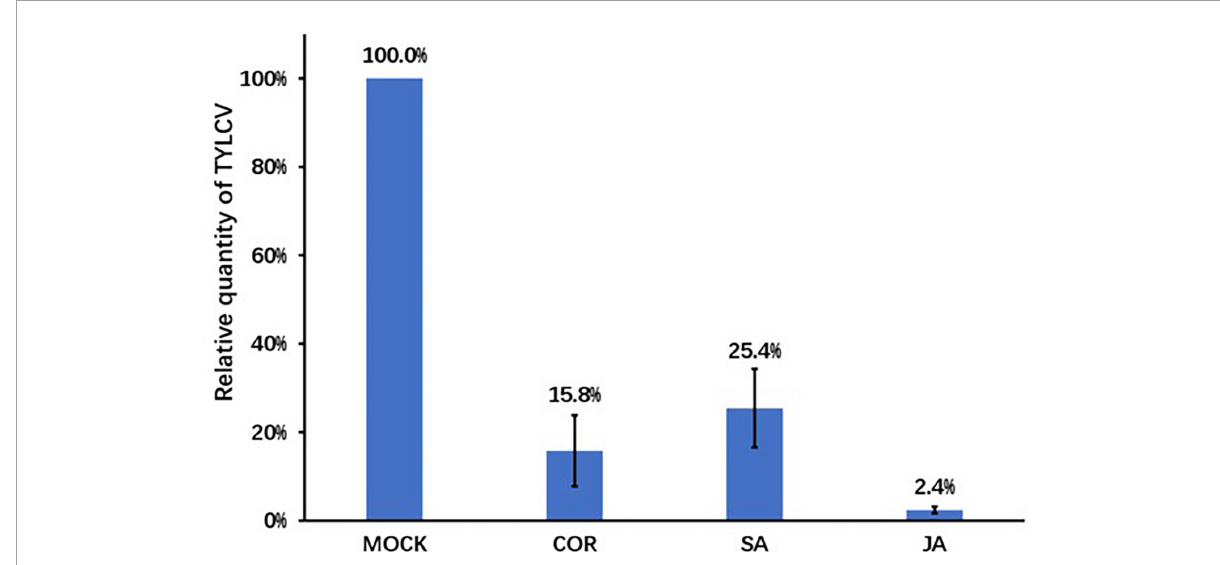
FIGURE1 The relative tomato yellow leaf curl virus (TYLCV) contents in tomato leaves. Pre-treatment of coronatine (COR) (0.1 µ M), salicylic acid (SA) (0.5 mM), jasmonate acid (JA) (0.5 mM), or mock was followed by the inoculation of the TYLCV infectious clones. Leaf samples were collected 7 days post infection. TYLCV levels were determined using qPCR and the TYLCV levels in the mock leaves were set to 1. Shown are the mean and SEM from three independent biological replicates.